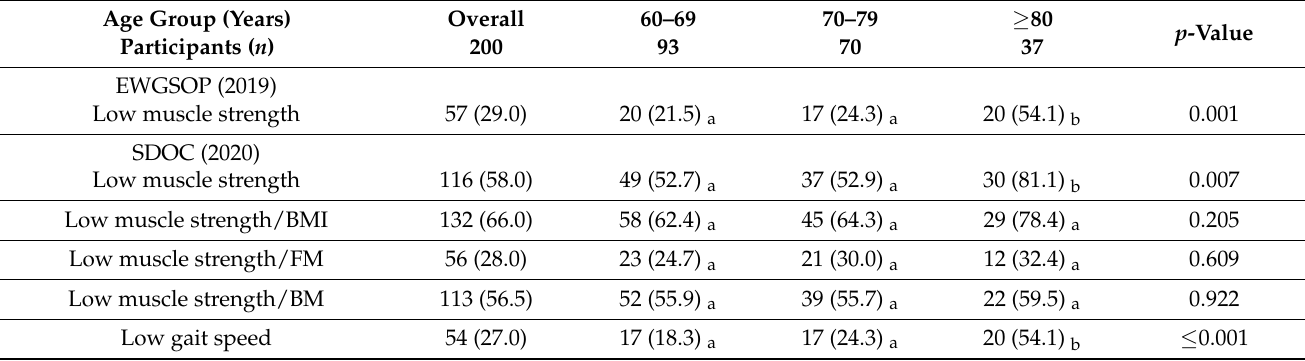
Table 2. Prevalence (%) of low muscle strength and low gait speed in elderly of Northern Brazil according to consensus definition of sarcopenia and age